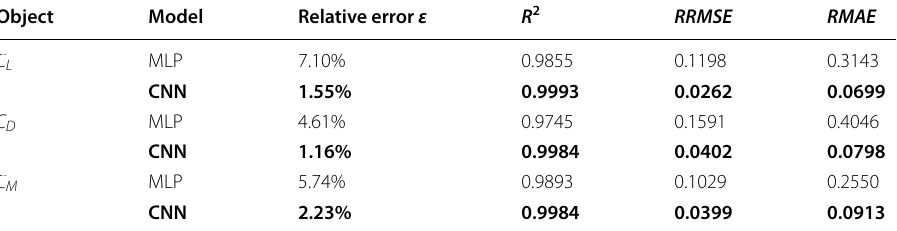
Table 8 Comparison of accuracy metrics for aerodynamic coefficient predictions of the baseline wing by MLP and CNN at different Mach numbers and angles of attack Object Model